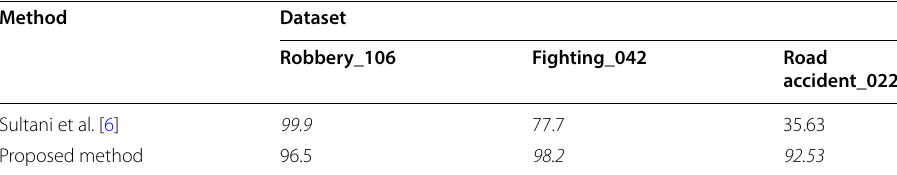
Table 3 The accuracy (%) evaluation of tested videos between full-frame and our proposed locality